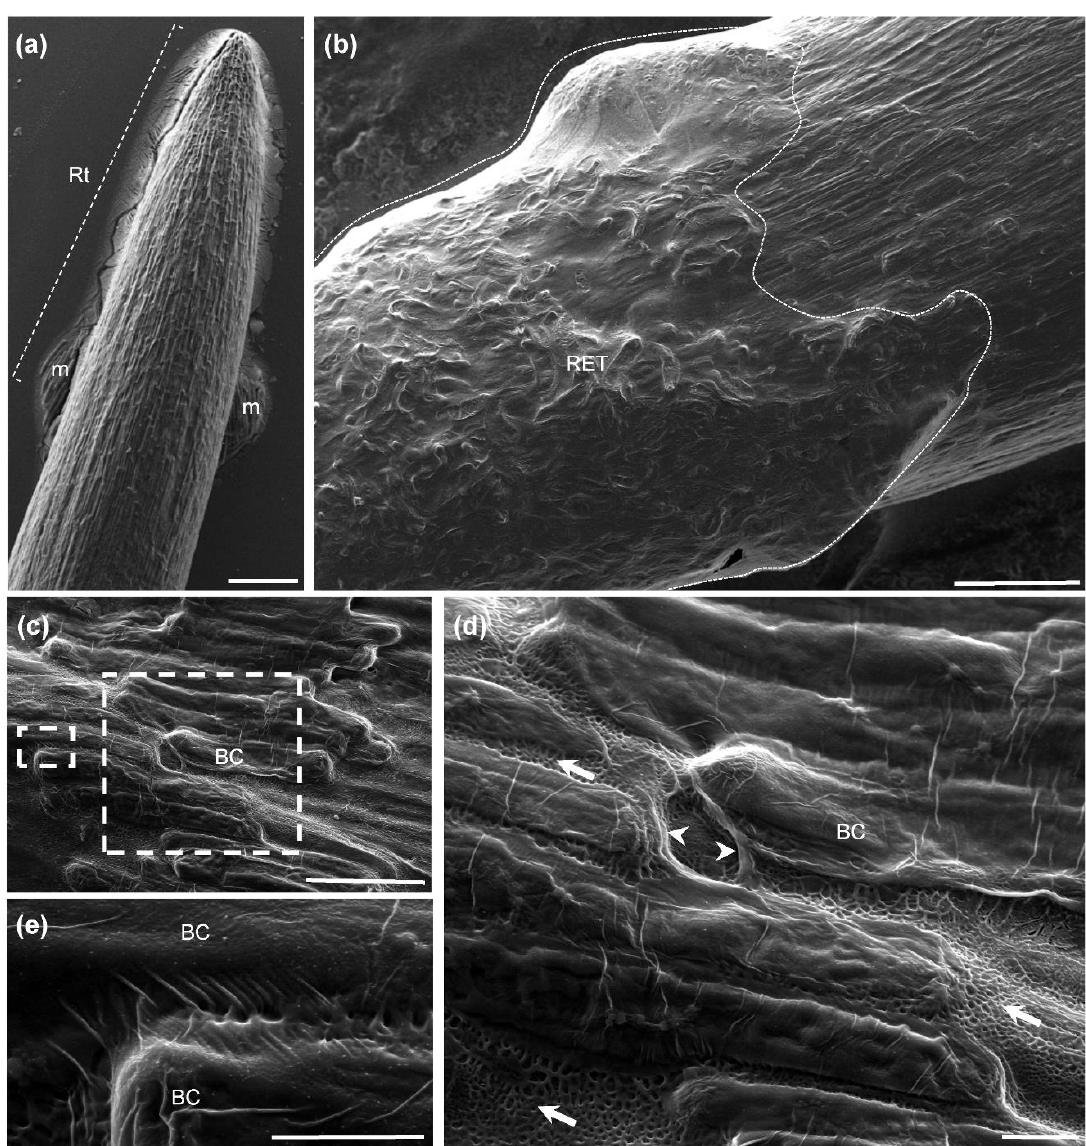
Figure 1. Morphology of a soybean root tip, border cells and mucilage observed by cryo-scanning electron microscopy. Micrographs showing a root tip surrounded by border cells and mucilage. ( a – c ) Border cells appear to be “glued” over the root surface and coated by dense extracellular material. ( d , e ) The material forms a fibrillary structure between the cells (white arrowheads), and fibrous elements are also observed probably linking cells together (white arrows). Boxed regions in ( c ) are shown at higher magnification in ( d , e ) to reveal details of the secreted mucilage. BC, border cells; m, mucilage; Rt, root tip; RET, Root Extracellular Trap. Scale bars: ( a , b ) 200 µm; ( c ) 100 µm; and ( d , e ) 10 µm.